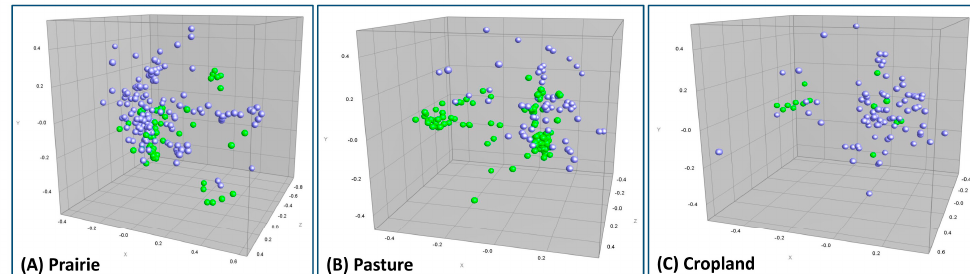
Figure 5. Comparison of the composite ERIC-Riboprint DNA fingerprints of the soil (green) and water runoff (purple) E. coli isolates by multidimensional scaling—( A ) Prairie, ( B ) Pasture, and ( C ) Cropland.